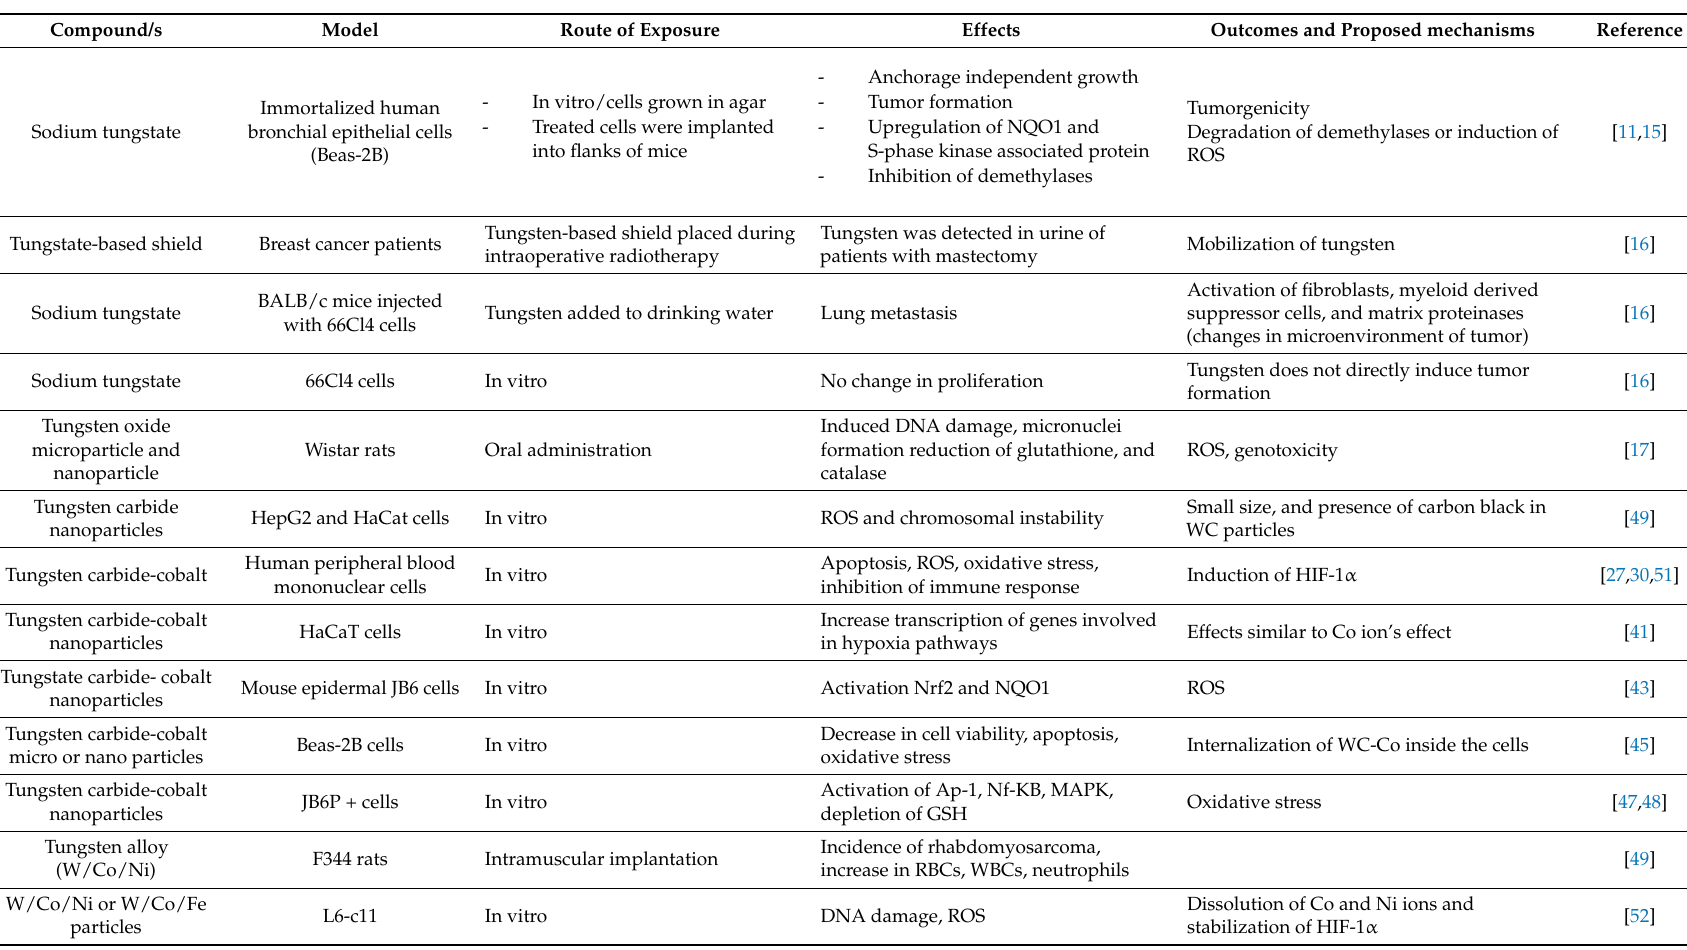
Table 1. Summary of the effects of tungsten compounds. Ap-1: activator protein; Co: cobalt; GSH: glutathione; HIF-1 α : hypoxia inducible factor 1- α ; MAPK: mitogen-activated protein kinase; Nf-KB: nuclear factor kappa-light-chain-enhancer of activated B; Ni: Nickel; NQO1: NADPH dehydrogenase quinone 1;